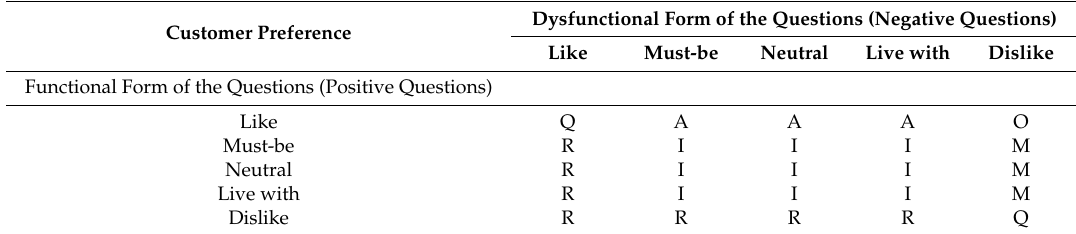
Table 1. Quality attribute classification in the Kano